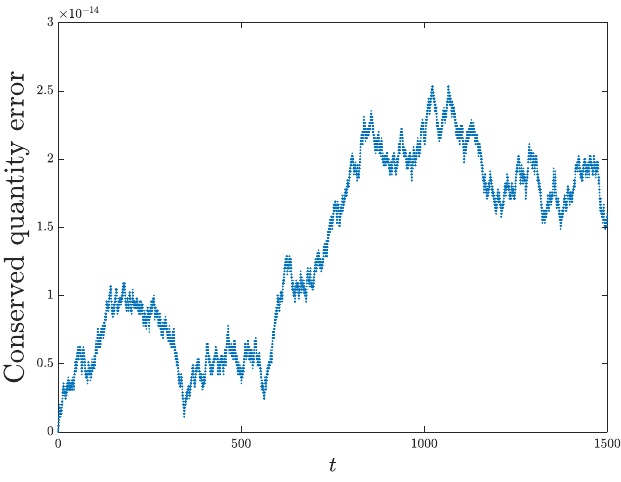
Figure 1. Errors in the conserved quantity I for Example 1 with h = 0.1.